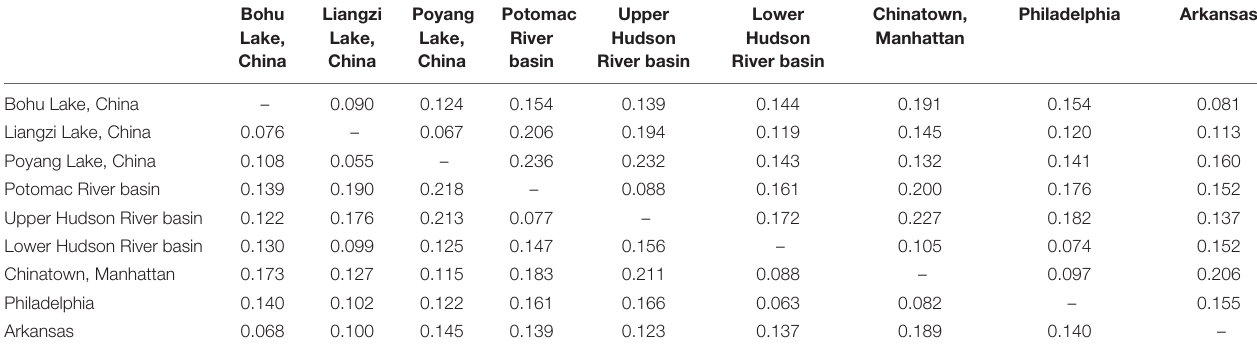
TABLE 3 | Upper and lower confidence interval limits for pairwise genetic distances (Fst) between Channa argus putative populations.